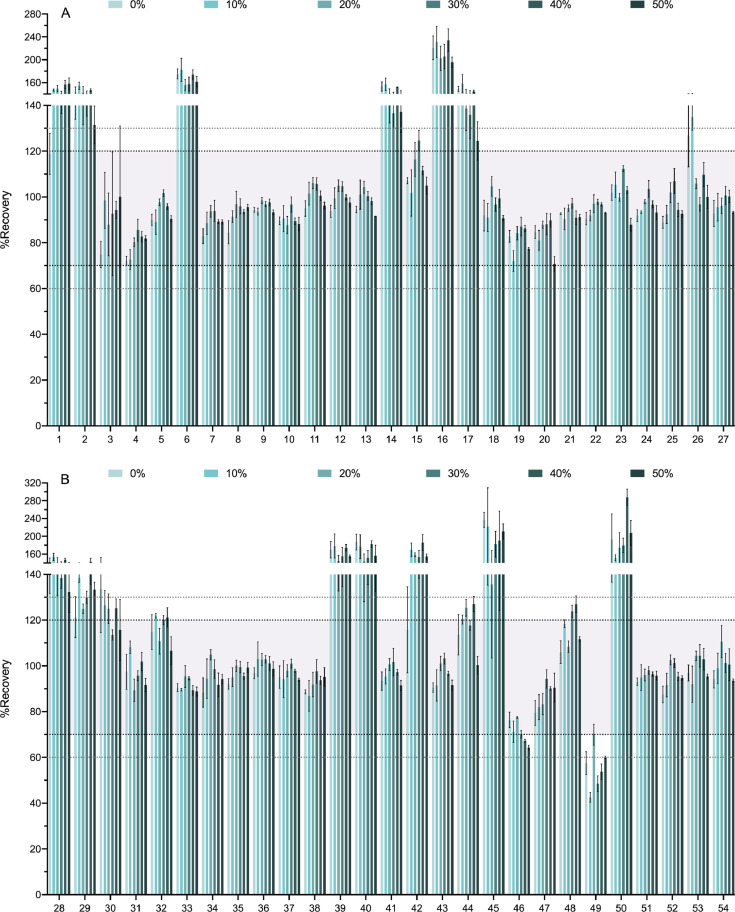
Soil sample moisture effect on the recovery percentages. In Fig. 4 we show the effect of soil moistening on the recovery percentages of the 218 analytes. Various percentages of soil moisture were tested (0%, 10%, 20%, 30%, 40%, and 50% water). The compounds are numbered according to the relation in Table 1. Bold-dotted lines shows the recovery limits recommended by the SANTE guide as acceptable (70% and 120%). Since the same guide also permits an expanded 60–130% when the results are highly reproducible these limits are also marked with dotted lines. For clarity the graph has been divided in 8 panels.